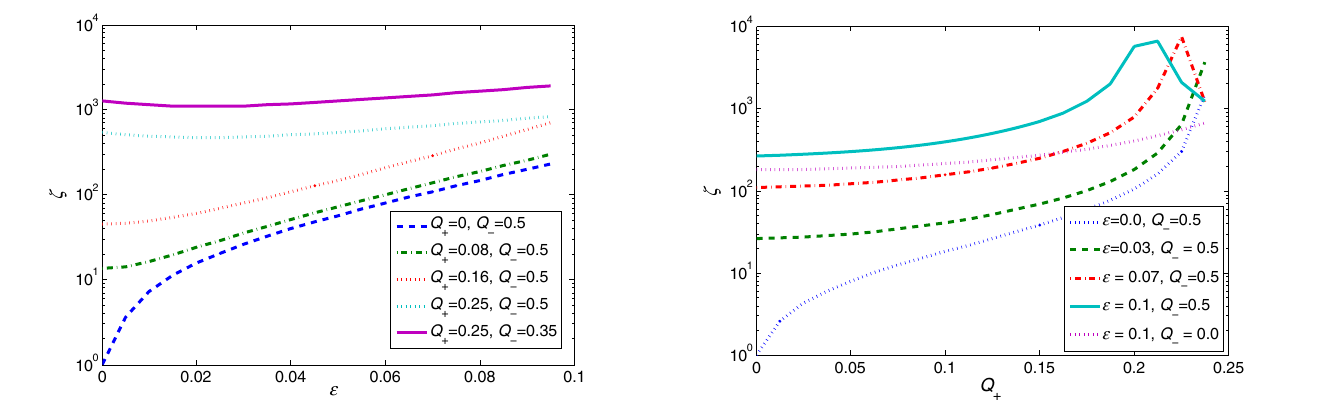
FIG. 7. The dynamical range of the phase gate as a function of the Josephson asymmetry ϵ for a set of gate charge values Q ð Q 1 þ Q 2 Þ and Q − ¼ Q 1 − Q 2 (expressed in units of 2 e ). The best dynamic range is found for Q 1 þ Q 2 ¼ 1 = 4 , corresponding to a phase of χ ¼ π = 2 in Eq. (18). Here, the dynamic phase error and the minimal gap differ by 3 orders of magnitude, allowing the gate to function for a significant range of ramping